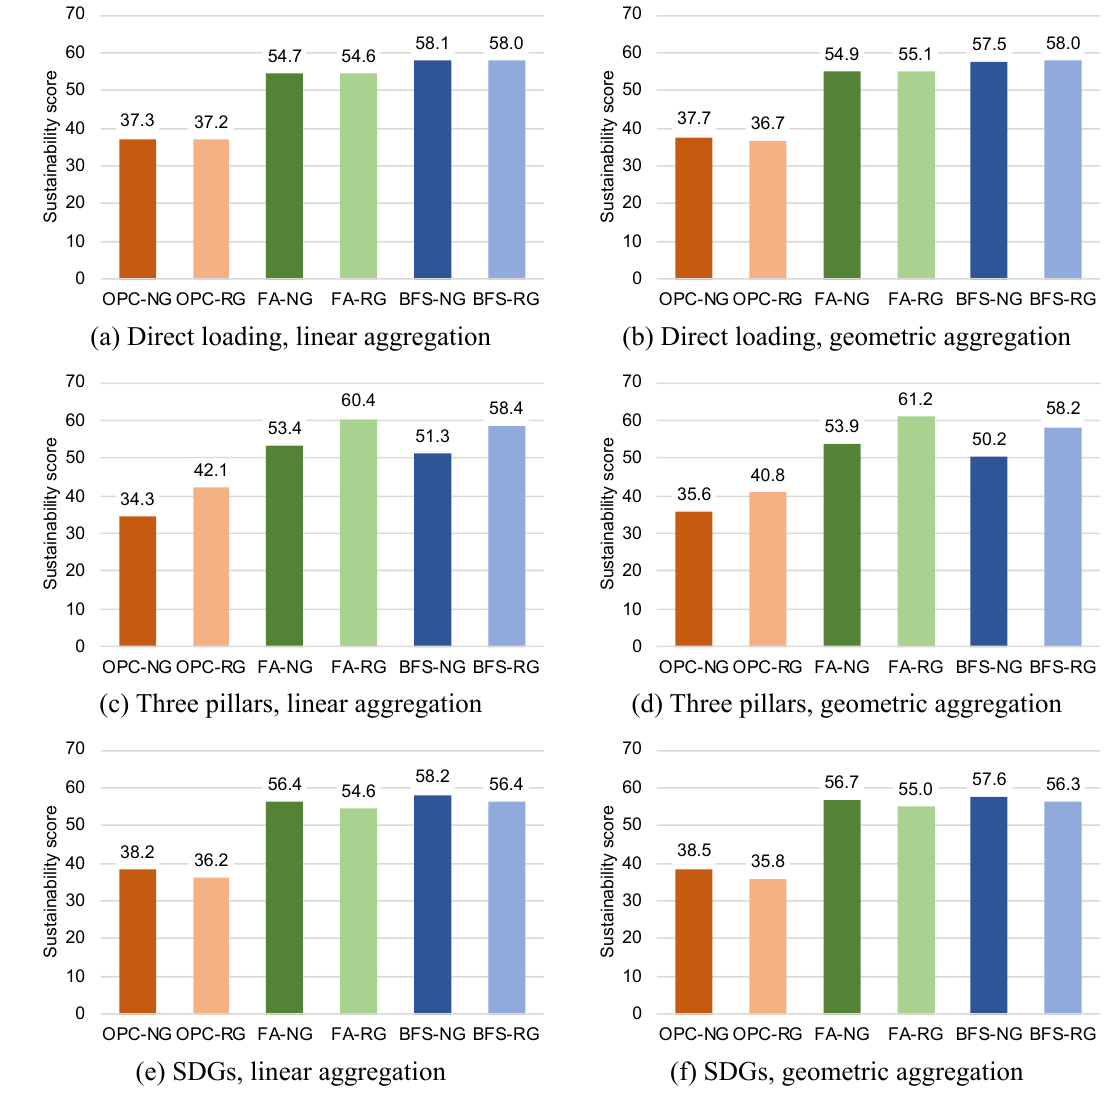
Figure 3. Sustainability scores by analytical